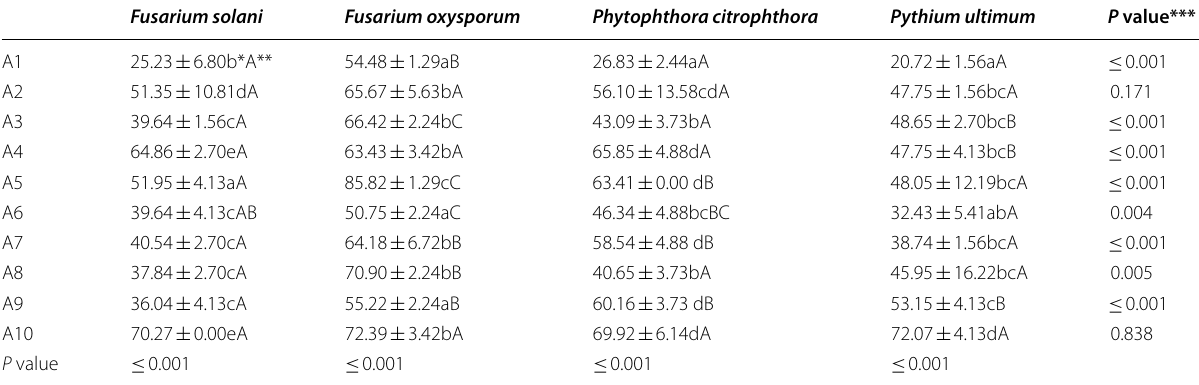
*Means standard error in the column for each parameter followed by the same lowercase letter were not significantly different according to SNK test at P ± **Means standard error in a row followed by the same capital letter were not significantly different according to SNK test at P ± ***Probabilities associated with individual F